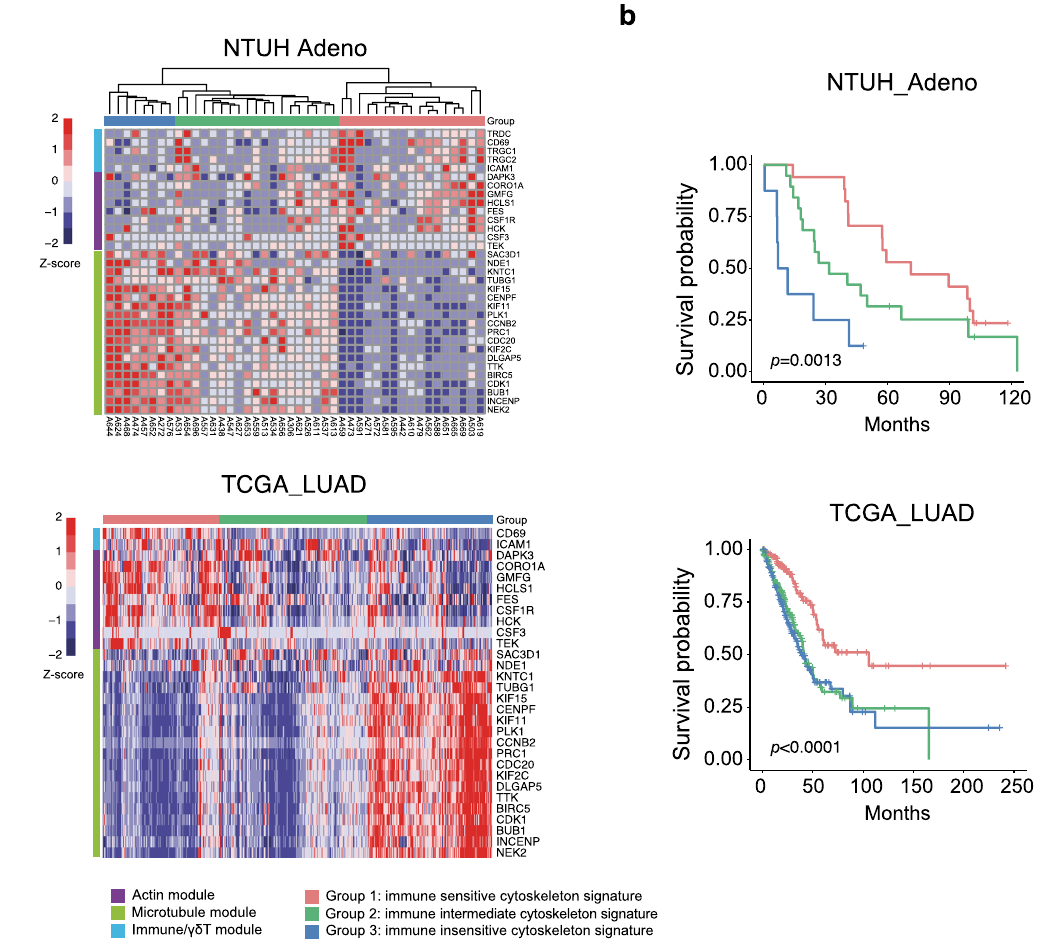
Fig. 7 Strati fi cation of patients with lung cancer by the immune cytoskeleton gene signature. a Heatmaps of immune cytoskeleton gene signature derived from mRNA-seq data of primary lung adenocarcinoma tumor tissues in patients at National Taiwan University Hospital (NTUH, upper) and from The Cancer Genome Atlas (TCGA, lower). b Overall survival analysis of the NTUH (upper) and TCGA (lower) lung adenocarcinoma patient cohorts strati fi ed by immune cytoskeleton gene signatures associated with different γδ T susceptibilities. The p value is calculated by the Mantel-Cox test